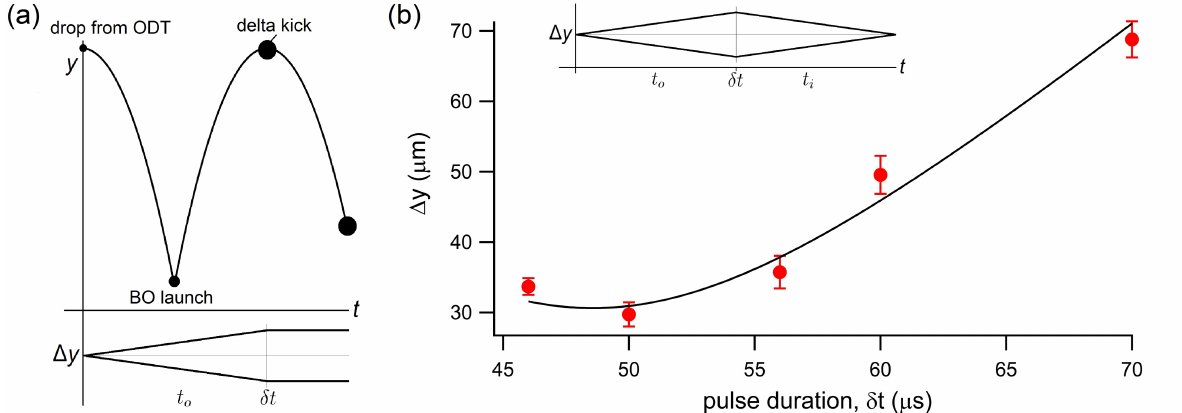
Figure 6. Delta-kick collimation and characterization sequences. ( a ) space-time diagram depicting the trajectory of the expanding atom cloud. The DKC pulse of duration δ t is applied at time t o after release from the ODT to achieve collimation; ( b ) DKC characterization by measuring the size of a refocused atom cloud at time t i after the delta-kick. The black curve is a best-fit hyperbola, ( ∆ y ) 2 / ( ∆ y min ) 2 − ( δ t − δ t min ) 2 / C 2 = 1, returning a minimum observable size ∆ y min = 30.6 ± 2.0 µ m with a corresponding δ t min of 48.6 ± 1.9 µ s. The DKC beam power here is approximately 22